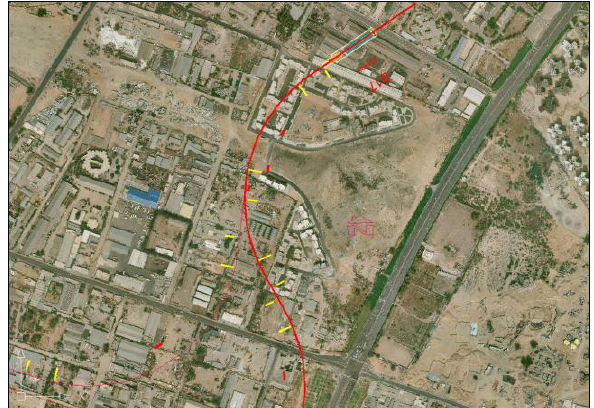
Figure 6. Deep alignment line led away from a planned traffic